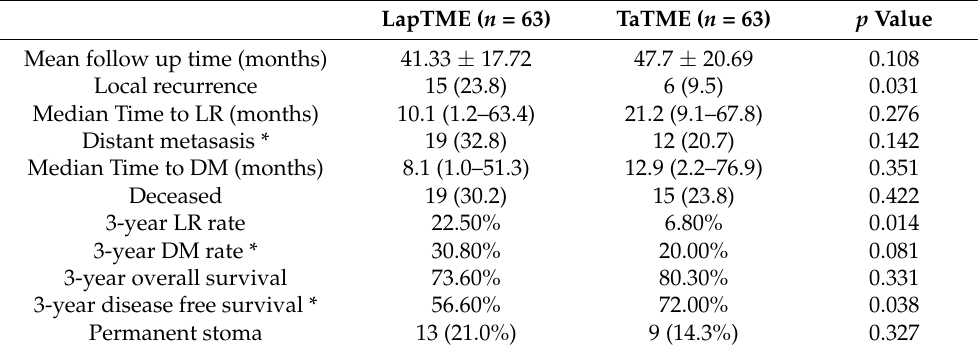
Table 5. Post-matching of long-term outcomes among patients with low rectal cancer underwent restorative